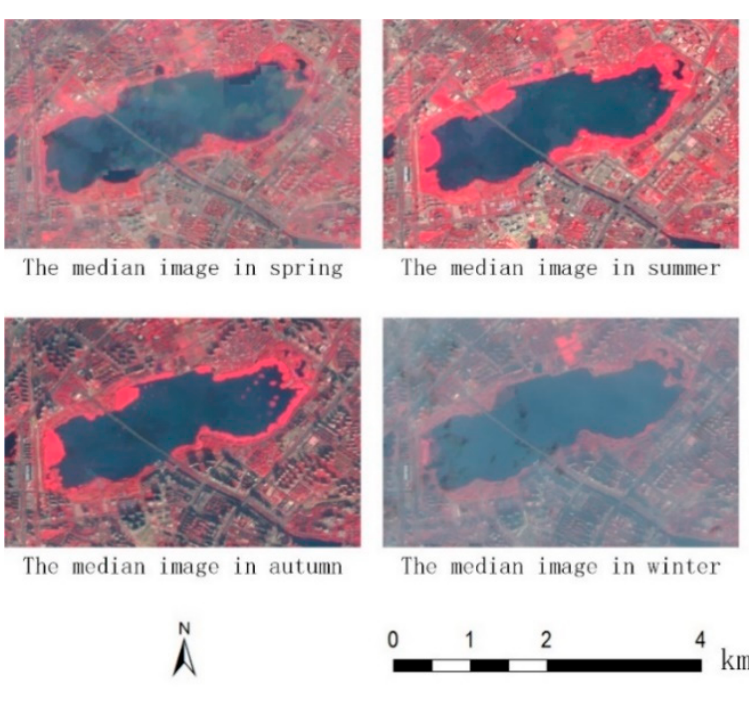
Figure 2. A sample of Sentinel-2 data and the sample location is Shahu Lake, Wuhan. The false- color composite multispectral images: Red: B8; Green: B4; Blue: B3 were shown.